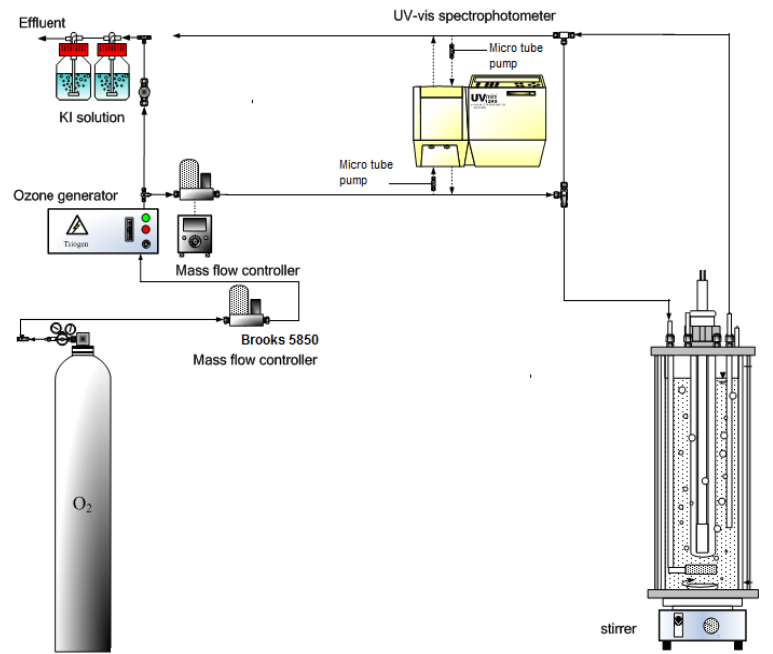
Figure 2. Flow chart of sludge pretreatment by ozonation.